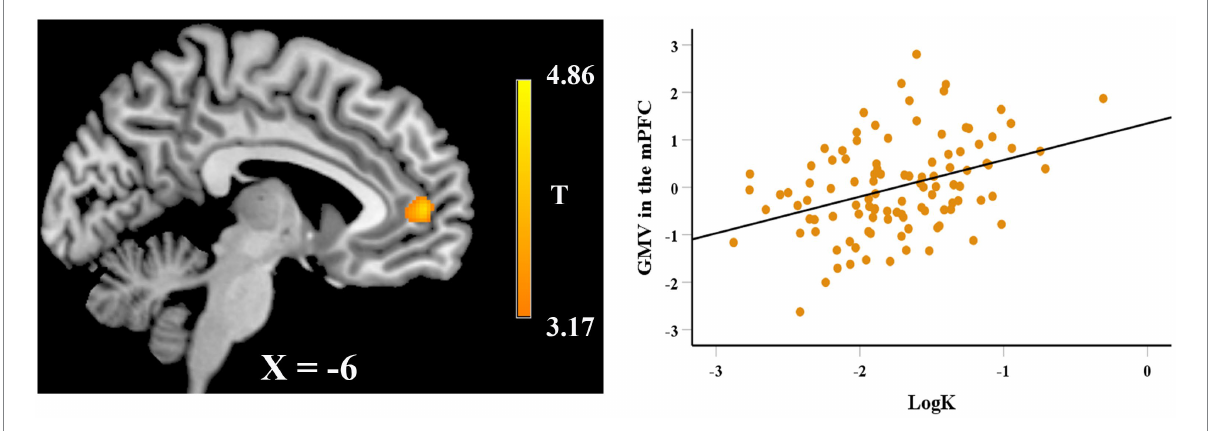
FIGURE 3 Whole-brain regression analysis showed that delay discounting (logk) was significantly correlated with regional GMV in the mPFC. Scatter plot on the right side is presented for visualization purposes only and not to be used for statistical inference.